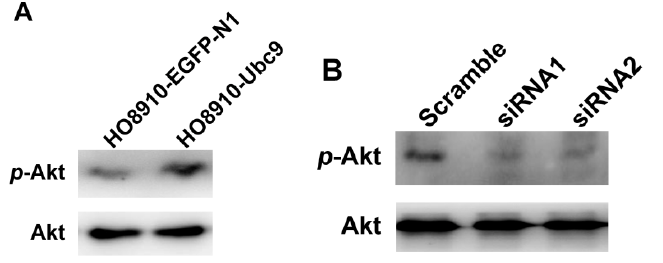
Figure 5. PI3K/Akt signaling is required for Ubc9 in accelerating HO-8910 cell proliferation. ( A ) Western blot profiles of Akt and p-Akt proteins in HO8910 and HO8910-Ubc9 cells; ( B ) Western blot profiles of Akt and p-Akt proteins in Scramble- and Ubc9-siRNA-transfected HO8910-Ubc9 cells; ( C ) The proliferation of HO8910-Ubc9 cells were inhibited after being treated with LY294002. Data are means ± SEM from 3 separate experiments. * p < 0.01, compared with DMSO-treated HO8910-Ubc9